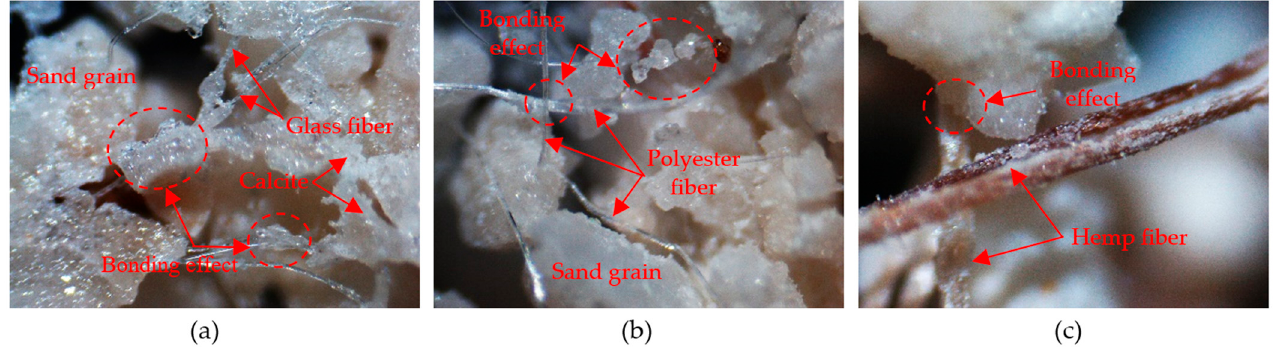
Figure 13. Digital LED microscope images of sand after microbial-induced calcite precipitation (MICP) reinforcement (50× magnification) at ( a ) 0.2% glass fiber, ( b ) 0.25% polyester, and ( c ) 0.25% hemp fiber.